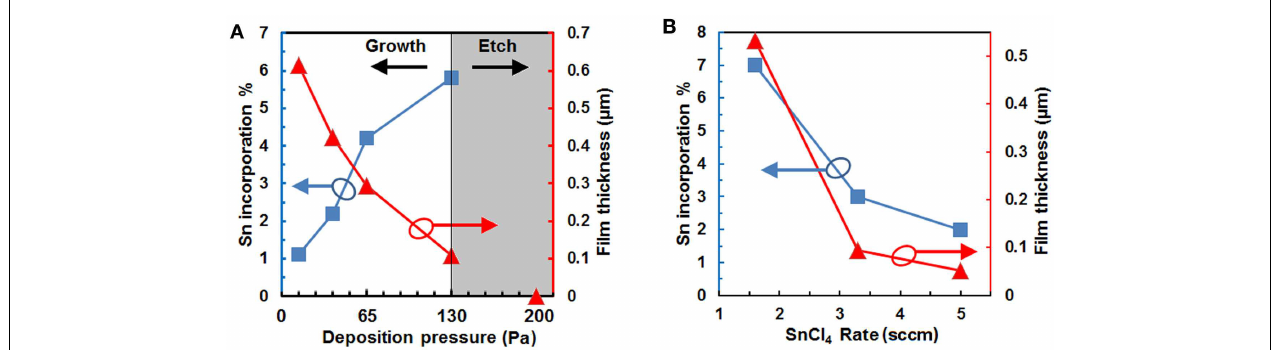
as a result of increase in the deposition pressure. (B) Tin incorporation and film thickness of the samples grown at 65Pa growth pressure versus GeH 4 /SnCl 4 flow ratios.